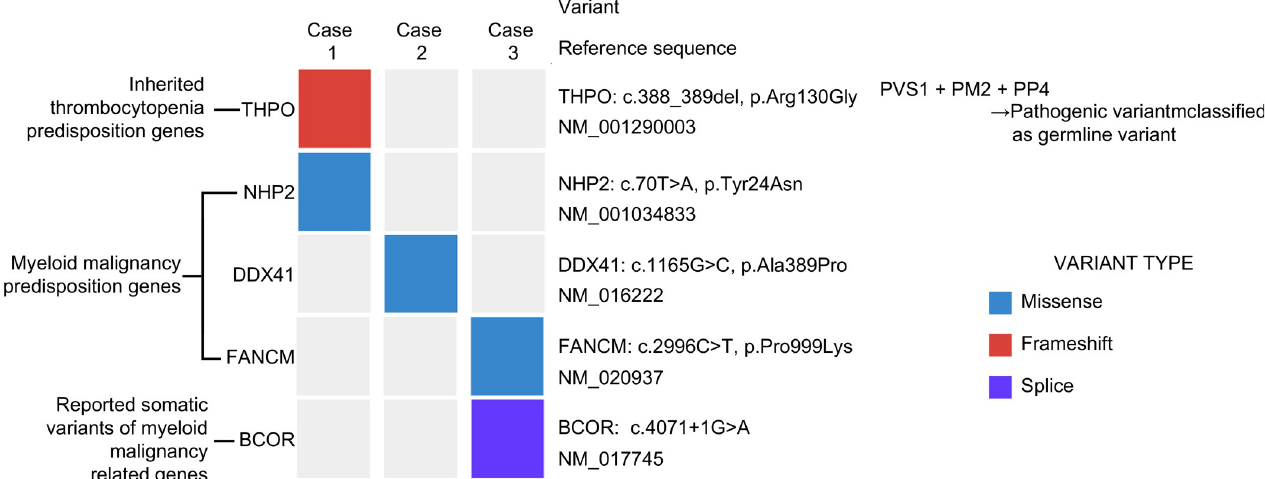
Fig 2. Heatmap showing gene variants of three MDS-EB2 patients with refractory cytopenia of childhood. Of all variants filtered out by targeted multigene sequencing performed on three patients, only those observed in the myeloid malignancy predisposition genes, inherited thrombocytopenia predisposition genes, and somatic variants of myeloid malignancy-related genes are represented. A frameshift variant in THPO and a missense variant in NHP2 were observed in patient 1. A missense variant in DDX41 was observed in patient 2. A missense variant in FANCM and a splicing variant in BCOR were observed in patient 3. Inherited thrombocytopenia predisposition genes were identified based on guidelines in Bury et al. [1]. Myeloid malignancy predisposition genes were identified based on the WHO criteria and NCCN guidelines. The somatic variant was identified based on the NCCN guidelines and reported in the COSMIC database. MDS-EB2, myelodysplastic syndromes with excess blasts-2; WHO criteria, World Health Organization classification of tumors of hematopoietic and lymphoid tissues; NCCN, The National Comprehensive Cancer Network; COSMIC, Catalog Of Somatic Mutations In Cancer.